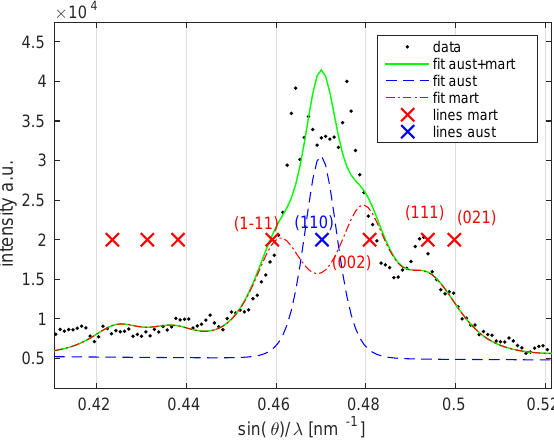
Figure 7. Central group of peaks proving the presence of R-phase. Positions of austenitic, resp. martensitic lines are denoted by crosses of the same color as the fit of the given phase (austenite is denoted by blue, martensite by red color). Green line stands for the sum of the former two fits, black dots are measured